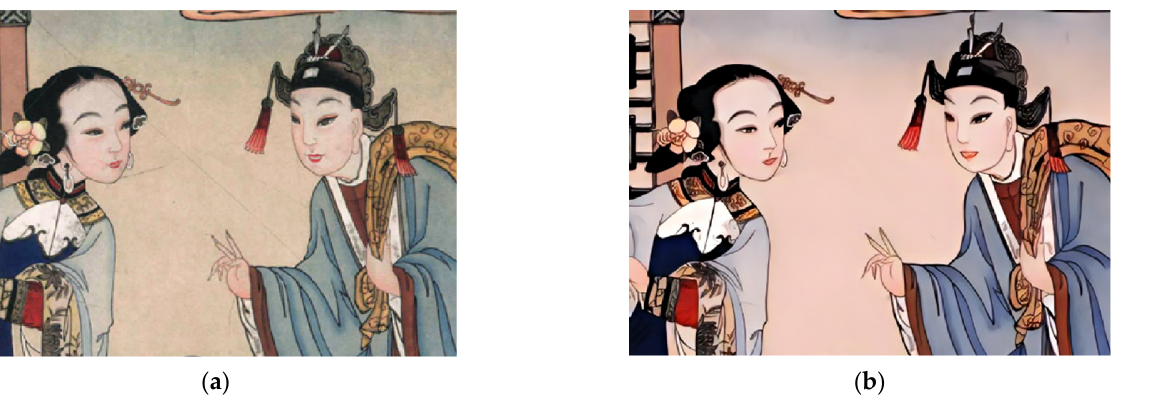
Figure 8. Assuming the pixels of the image line up in a